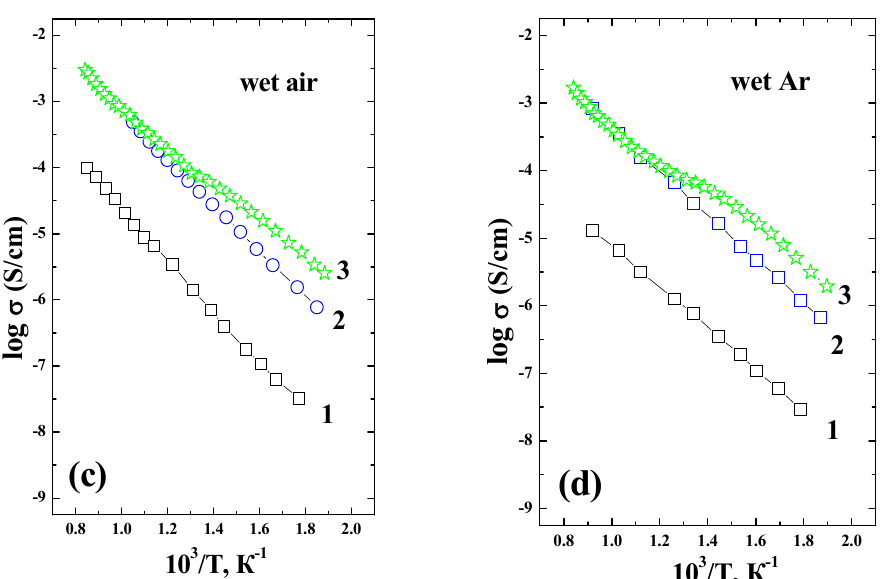
Figure 10. The temperature dependencies of conductivities for the BaLaInO 4 [24] (1), Ba 1.1 La 0.9 InO 3.95 [24] (2), and Ba 1.1 La 0.9 In 0.5 Y 0.5 O 3.95 (3) obtained under dry air ( a ), dry Ar ( b ), wet air ( c ), wet Ar ( d ).